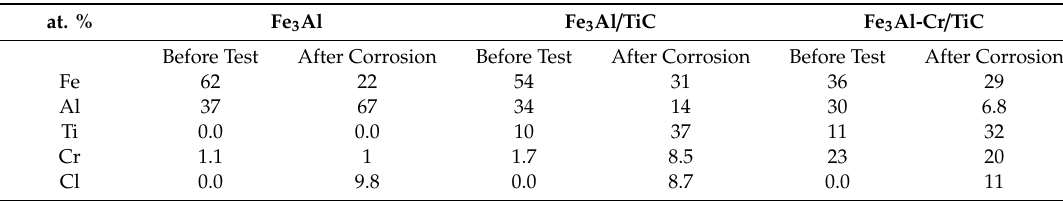
Table 5. XPS surface analysis of the samples (excluding carbon and oxygen) before and after polarization tests. The at. % is the normalized value for each element on the sum of all elements presented in the